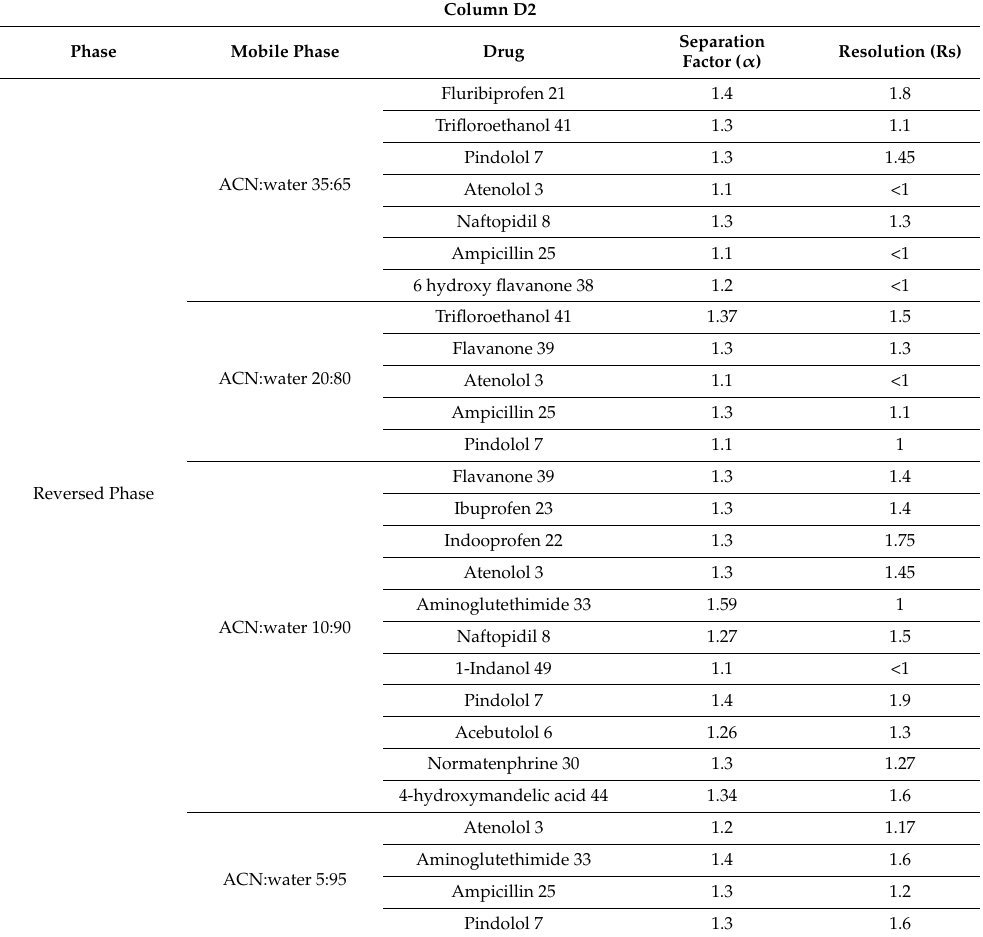
Table 3. Chromatographic parameters, separation, and resolution factors for the significantly resolved compounds on D2 (immobilized) column, using reversed mobile phases, flow rate: 1 µ L/min. Column D2